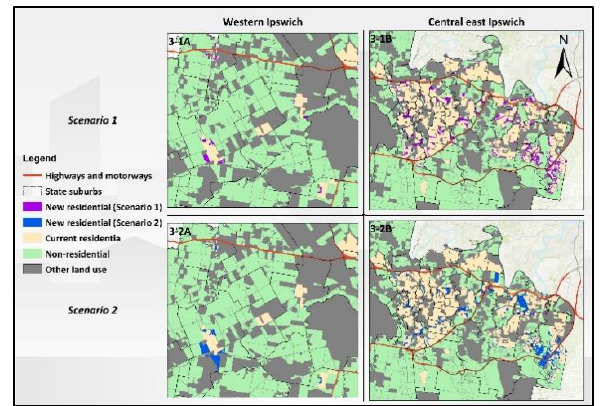
Figure 3 . Predicted scenario developments of newly residential areas (Year 2016 - 2031).